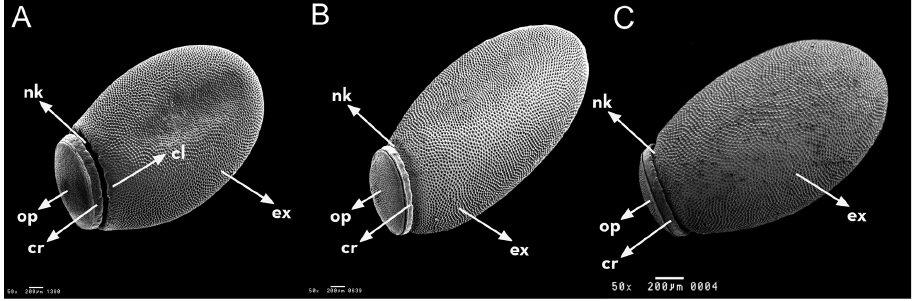
Figure 12. Eggs general vision of R. marabaensis sp. n. ( A ), R. prolixus ( B ), R. robustus ( C ). cl: colar; cr: chorial rim; ex: exochorium; nk: neck; op: operculum.